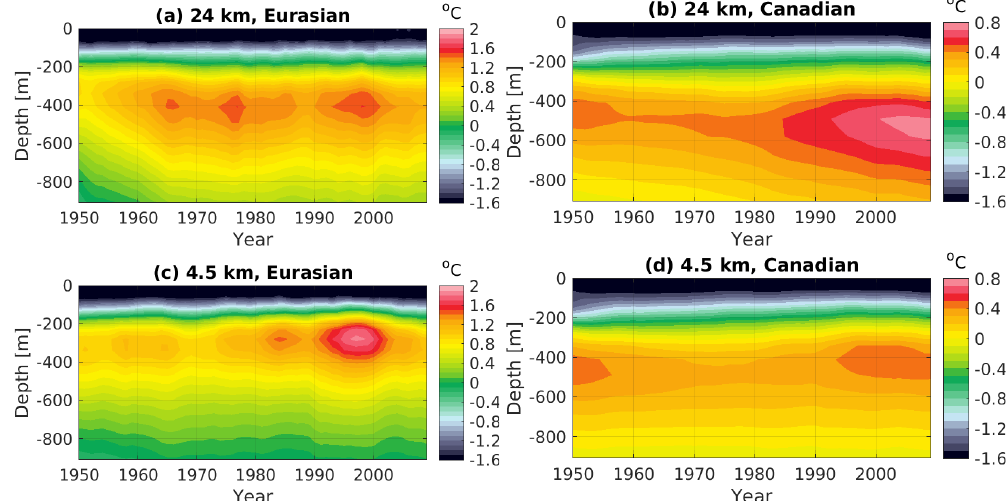
Figure 3. Hovmöller diagram of mean potential temperature for the (a) Eurasian Basin and (b) Canadian Basin obtained in the simulation LOW. Panels (c, d) are the same as (a, b) but for simulation HIGH. The whole integration period of 1950–2009 is